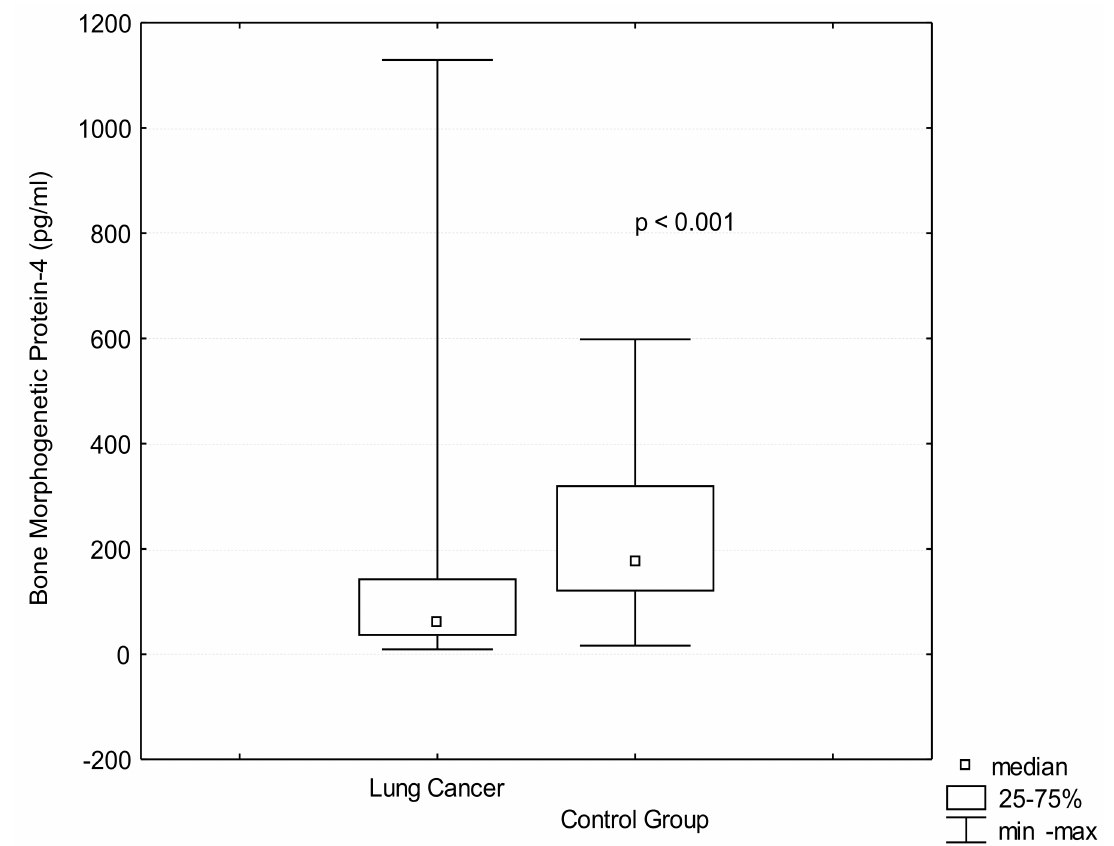
Figure 4. BMP-4 serum levels in lung cancer and control group. BMP-4 (bone morphogenetic protein-4). There were no differences in BMP-4 or TSP-1 levels in NSCLC as compared with SCLC patients. There were no differences in BMP-4 or TSP-1 serum levels in different histological subtypes of NSCLC, especially between the two most common histopathological types of NSCLC: adenocarcinoma and squamous cell lung cancer patients. Differences neither in TSP-1 levels (12,414.18 ± 11,650.28 ng/mL vs. 10,683.84 ± 10,534.9 ng/mL p = 0.712) nor in BMP-4 (103.60 ± 60.55 pg/mL vs. 166,70 ± 62.59 pg/mL p = 0.655) were found (Table 3). Table 3. TSP-1 and BMP-4 serum levels in different histopathological types of lung cancer. Parameters NSCLC ( n = 102) SCLC ( n = 9) p TSP-1 (ng/mL) 10,093.04 ± 10,716.06 10,292.44 ± 10,491.16 NS BMP-4 (pg/mL) 140.67 ± 60.55 114.23 ± 82.96 NS Squamous Cell Lung Cancer ( n = 36) Adenocarcinoma ( n = 22) TSP-1 (ng/mL) 10,683.84 ± 10,534.9 12,414.18 ± 11,650.28 NS BMP-4 (pg/mL) 166.70 ± 62.59 103.60 ± 60.55 NS TSP-1 (Thrombospondin-1), BMP-4 (bone morphogenetic protein-4), NSCLC (non small cell lung cancer), SCLC (small cell lung